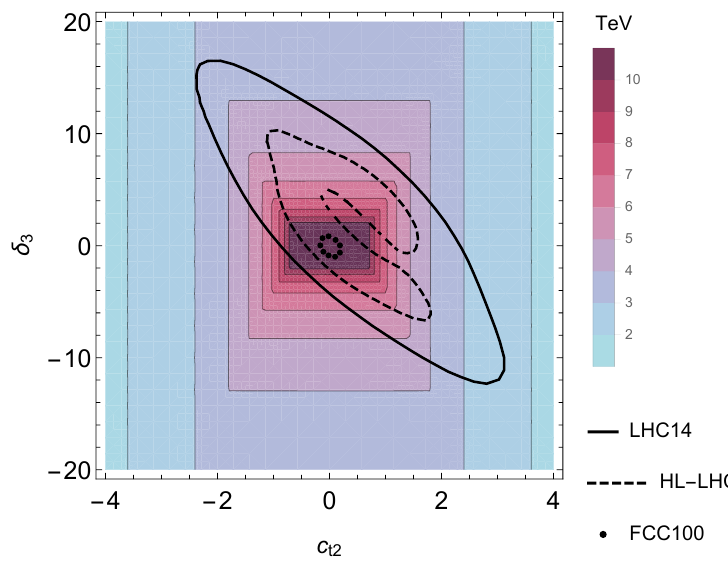
Figure 15 . Unitarity violating contours from δ 3 and c t 2 . The 95% C.L. projections from gluon fusion di-Higgs searches are shown for the LHC (solid) and for the HL-LHC (dashed), which were obtained by expanding the 1 σ contours of [36] by 1.6 to estimate the 95% C.L.